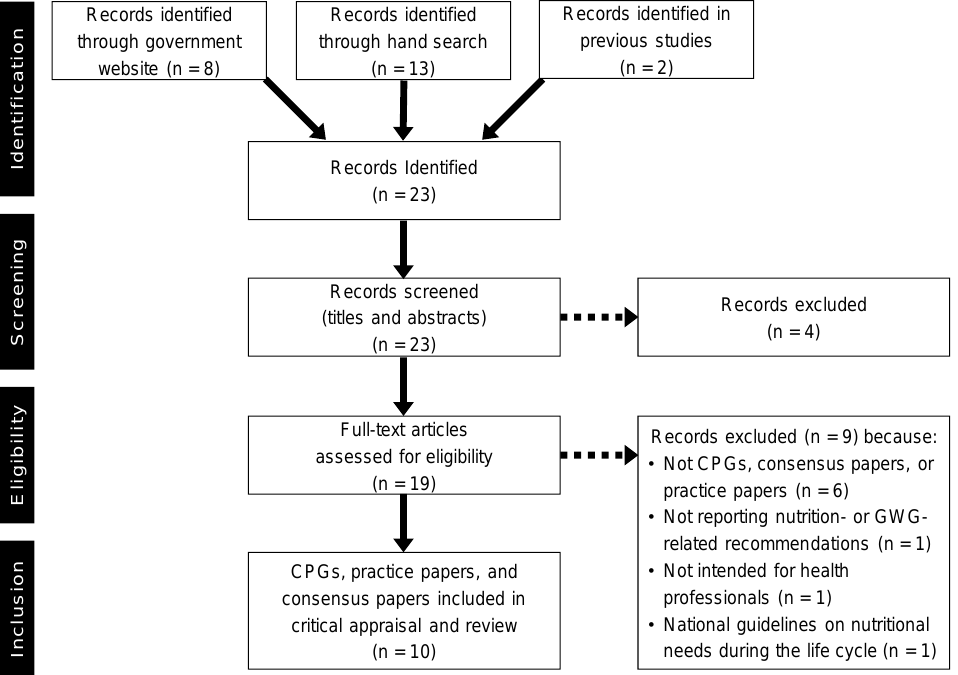
Figure 1. Flow diagram of the literature search process. CPG: clinical practice guideline.